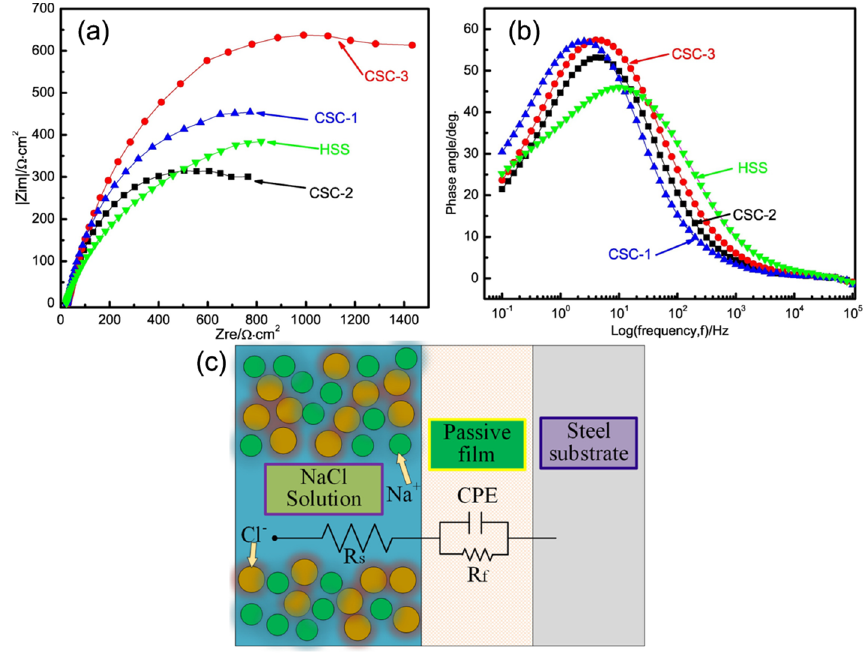
Figure 20. ( a ) Nyquist curves of HSS and different carbon steel claddings; ( b ) phase angle of HSS and different carbon steel claddings; ( c ) Schematic of tested materials [67].